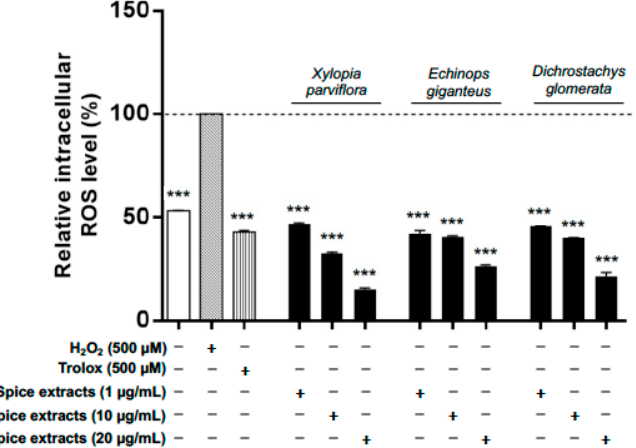
Figure 5. Concentration-dependent modulation of intracellular ROS release in SW 872 cells. The 3 most potent spice extracts were selected to evaluate the dose response. Concentration-dependent reduction of intracellular ROS production in SW 872 cells by selected spice extracts ( Xylopia parviflora, Echinops giganteus, and Dichrostachys glomerata ). Data are expressed as % of control taken as 100; mean ±SD, n = 3. One experiment ( n = 3) is shown as representative of 3 separated experiments, each in triplicate. Results are expressed as mean ±SD. *** p < 0.001 (one-way ANOVA multiple comparison).